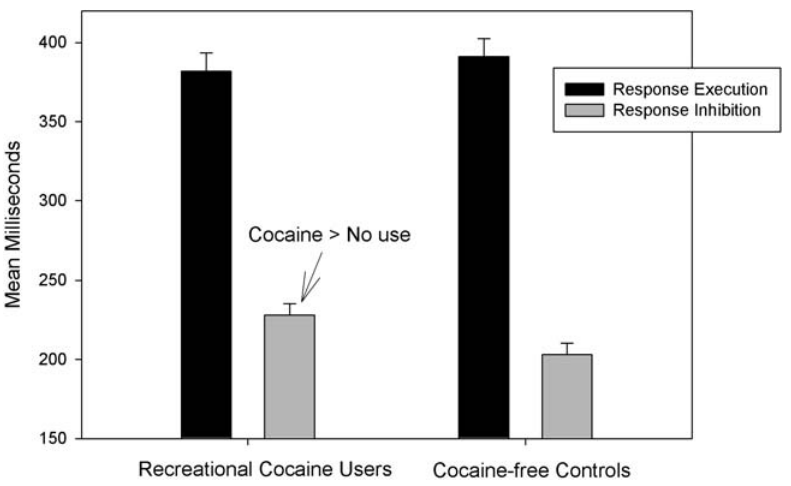
Figure 1. Mean go-signal RT (response latency) and mean SSRT (stopping latency) for recreational cocaine users and cocaine-free controls. Vertical capped lines atop bars indicate standard error of the mean.